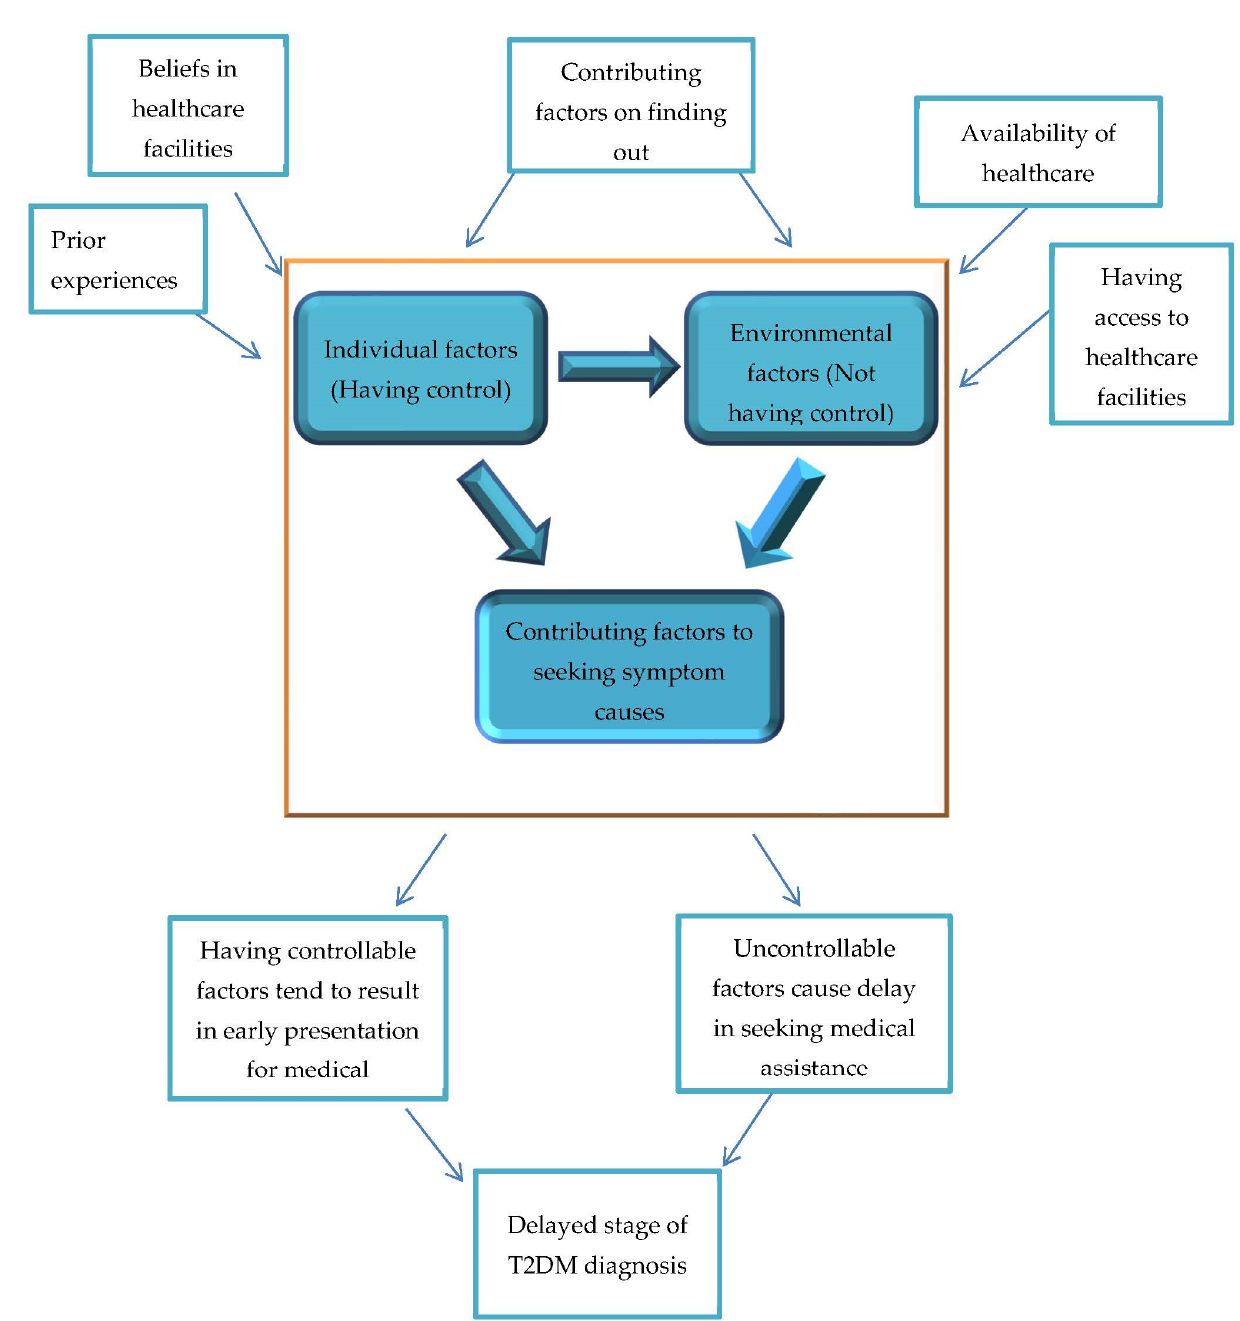
Figure 2. Controllable and Uncontrollable factors by individuals in finding